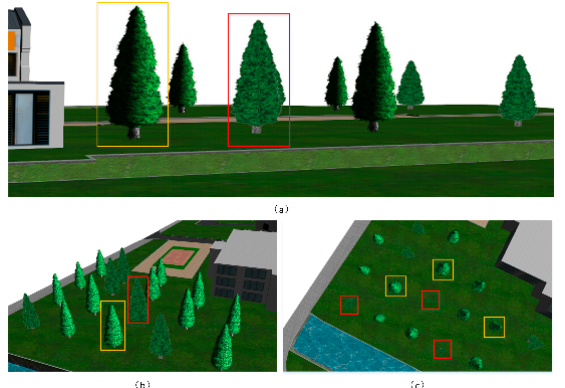
Figure 17. Comparison of the crossed-plane tree model (CPTM) (marked with red boxes) and the sphere-board-based tree model (SBTM) (marked with yellow boxes) for the particular tree species Sabina chinensis: ( a ) observed from a horizontal viewing angle, the SBTM presents a stereoscopic appearance, whereas the CPTM does not; ( b ) if the viewpoint is inclined gently toward the top side, the SBTM does not considerably change, whereas the CPTM gives a slight impression of slicing; ( c ) when the viewpoint is moved directly to the top of the trees, the SBTM looks reasonable, whereas the CPTM gives a considerable impression of slicing and even disappears.